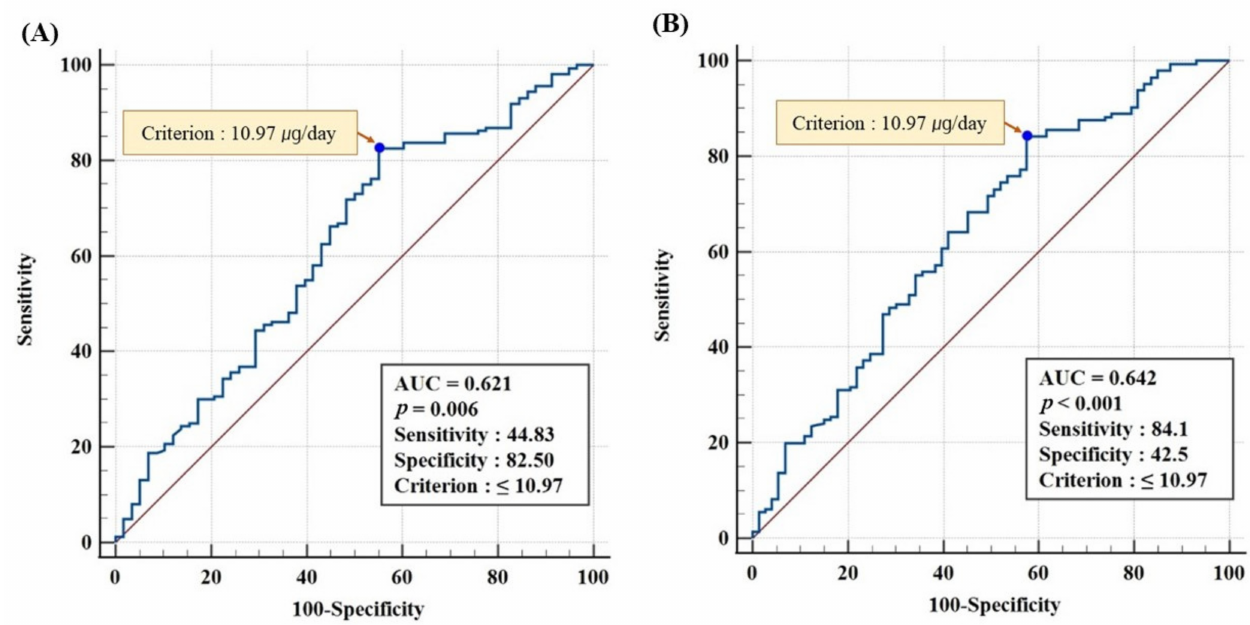
Figure 3. ROC analysis for assessing vitamin D intake at serum 25(OH)D levels ≥ 20 ng/mL ( A ) and ≥ 18.44 ng/mL ( B ). The vitamin D deficiency cutoff value, as per the American Institute of Medicine and the Endocrine Society of the United States, is 20 ng/mL ( A ) and the appropriate serum 25(OH)D level obtained from the total participants of this study was 18.44 ng/mL ( B